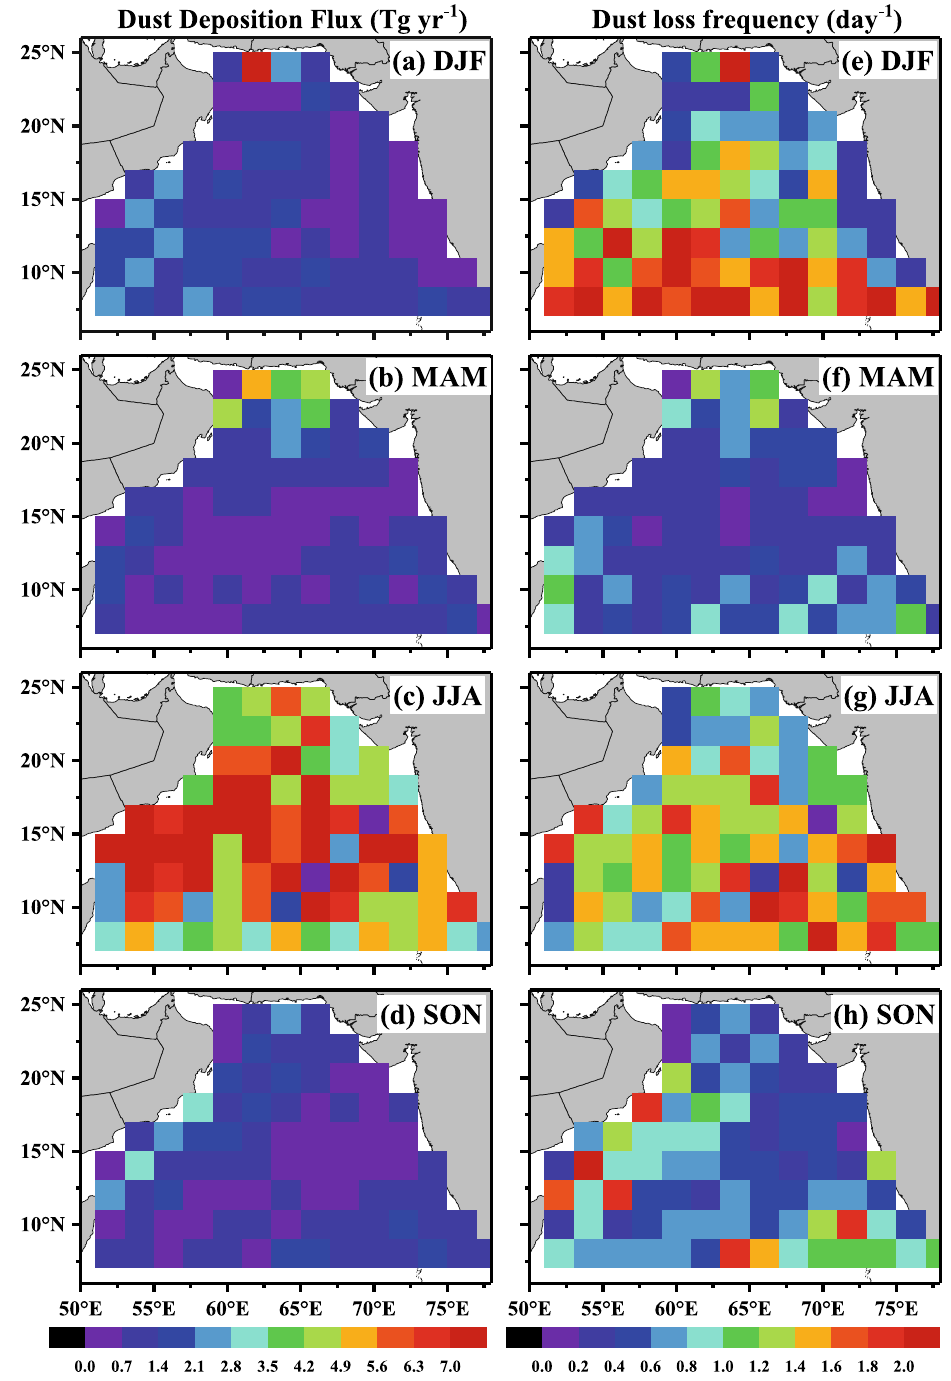
Figure 2. Spatial distribution (mean picture during 2007–2020) of dust deposition flux ( a–d ) and dust loss frequency ( e–h ) at different seasons over the Arabian